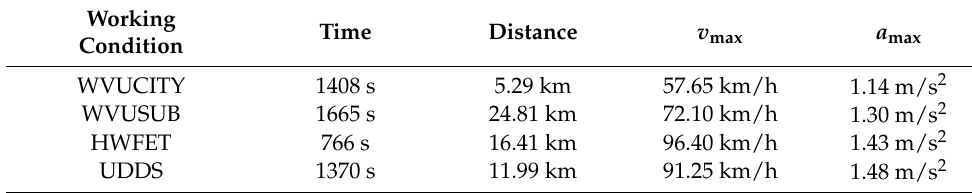
Table 1. Characteristic values of each working condition.